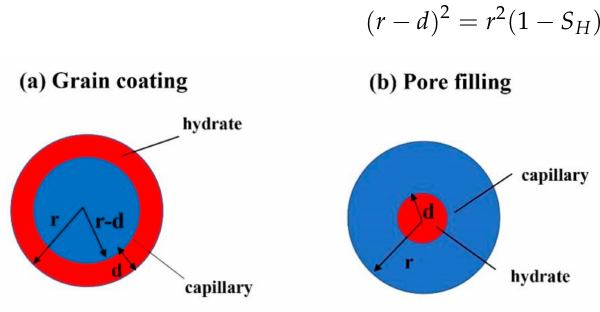
Figure 4. Two filling modes of parallel